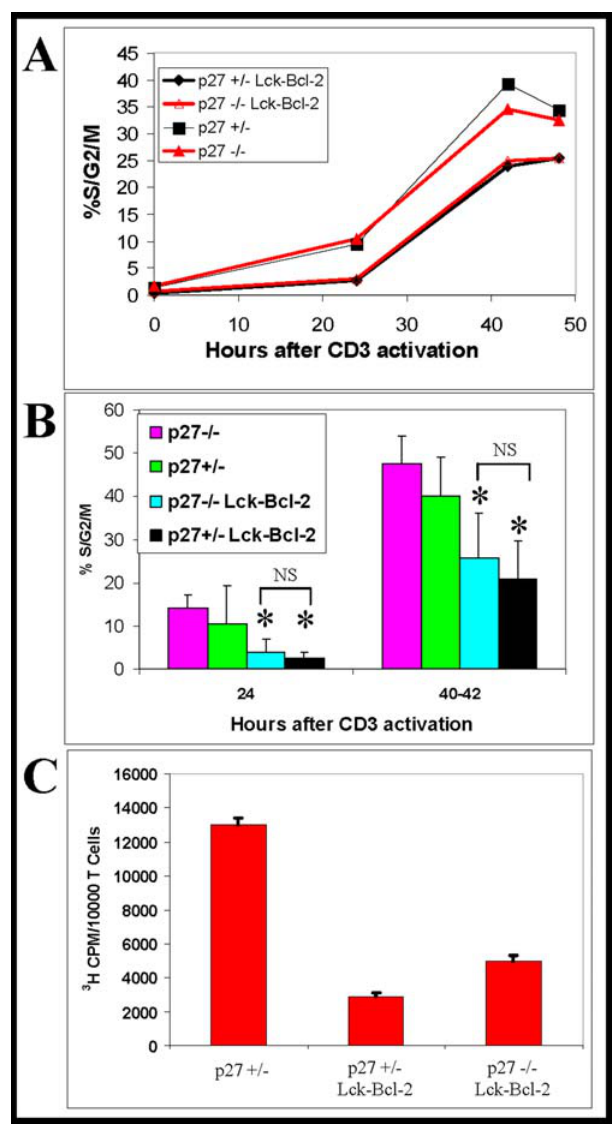
Figure 4. Bcl-2 retains anti-proliferative activity in p27 2 / 2 mice. SplenicT cells wereisolated,purified, andactivated withimmobilizedanti- CD3 antibody as described in the Materials and Methods. A) At the time pointsindicated,T cells were harvested andanalyzed forcell cycle using PI staining. The %S/G2/M at each time point is shown. This experiment is representative of at least three independent experiments. B) Shown is the %S/G2/M (mean 6 SD) cell cycle analysis at 24 and 40–42 hours following activation from multiple independent experiments from mice of the indicated genotypes. The differences between the Lck-Bcl-2 samples (p27 + / 2 vs p27 2 / 2 ) were not significant (NS). * P , 0.01 versus the control p27 + / 2 and p27 2 / 2 mice using the unpaired Students T test. C) Proliferation of T cells of the indicated genotypes was determined by